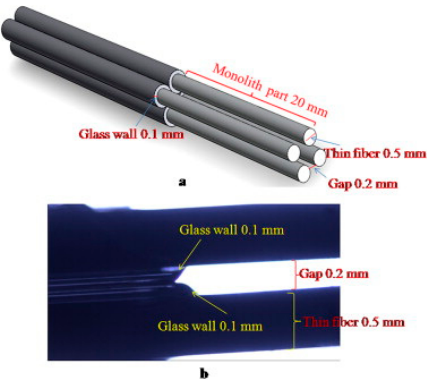
Figure 3. Schematic diagram of MMF-SPME ( a ) and the microscope image of the gap between thin fibers ( b ) [81].